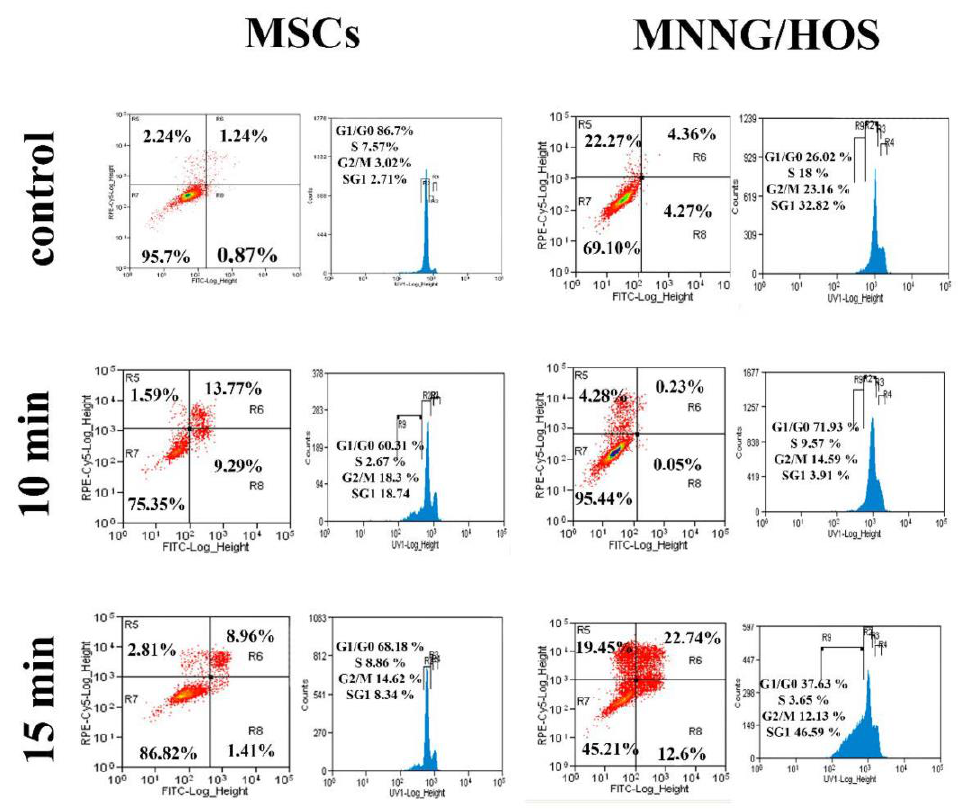
Figure 3. The flow cytometry analysis of cells (MSCs and MNNG/HOS) 72 h after CAAP irradiation with 10 and 15 min exposure time. The red dots on the left side of each diagram show the distribution of cells by quadrant depending on R5—necrosis, R6—late apoptosis, R7—living cells, R8—early apoptosis. The histograms show cell distribution by cell cycle phases: G 1 /G 0 , S, G 2 /M, and SG 1 (G 1 subphase). The digital data on the histograms are the average values for three independent